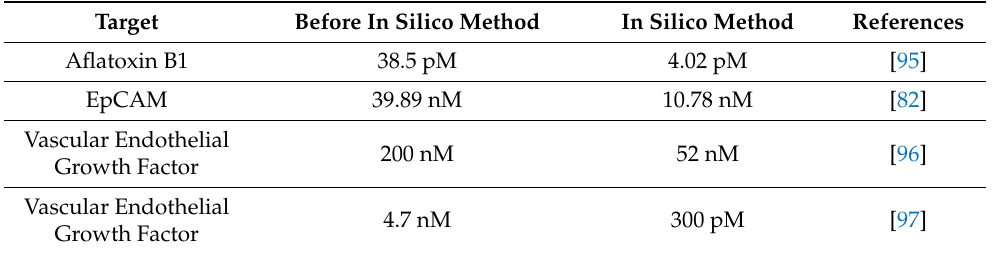
Table 1. Comparison of the dissociation constant of the aptamer after in silico process. Target Before In Silico